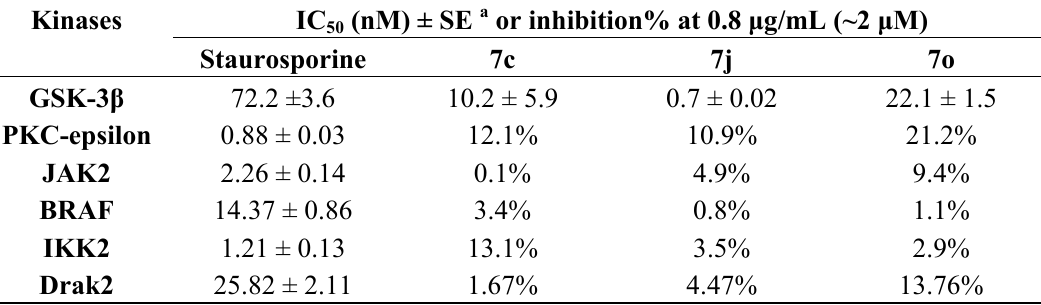
Table 2. The selectivity to tested kinases of target compounds 7c , 7j and 7o .